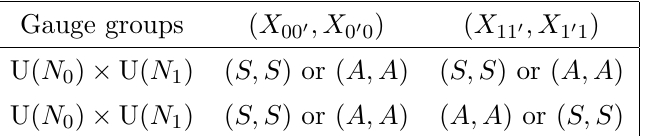
Table 15. The unoriented involution ^(cid:10) of C 3 = Z 0 4 . \A" stands for \Antisymmetric representation", while \S" for \Symmetric